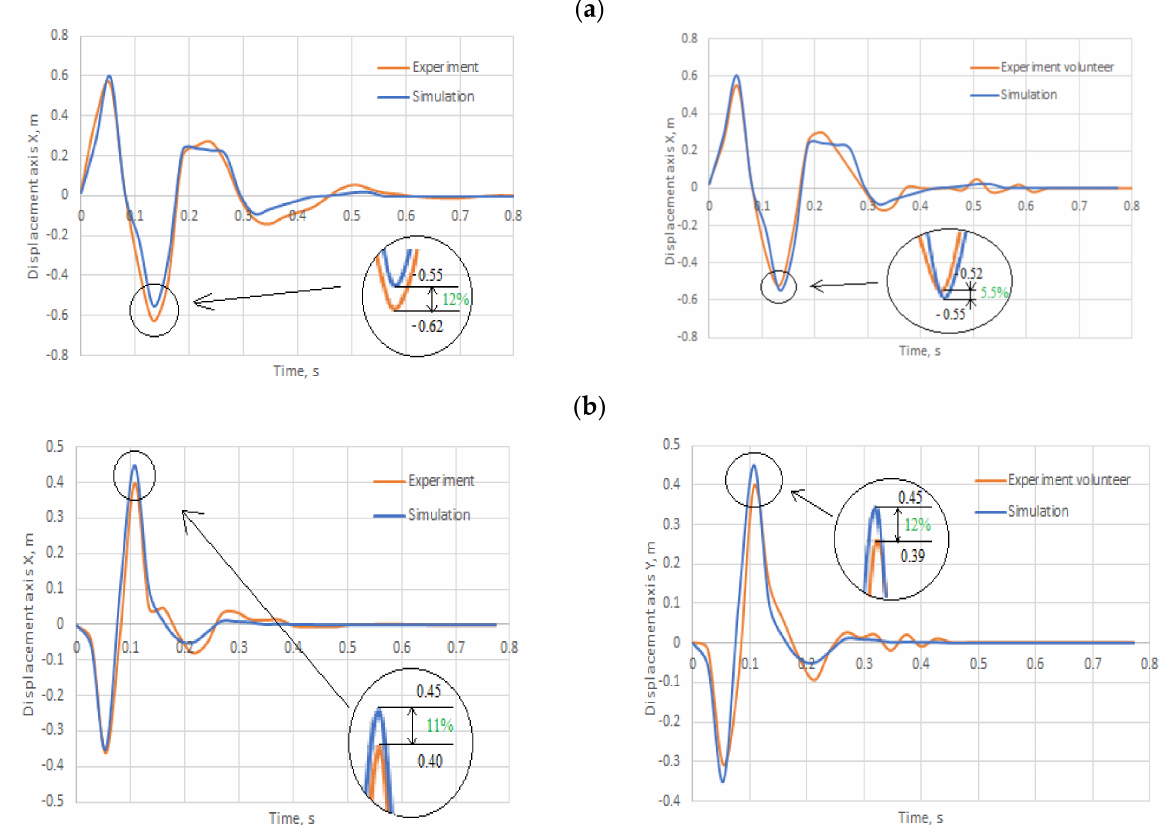
Figure 7. Displacement of the dummy head ( a ) relative to the X axis, ( b ) relative to the Y axis.